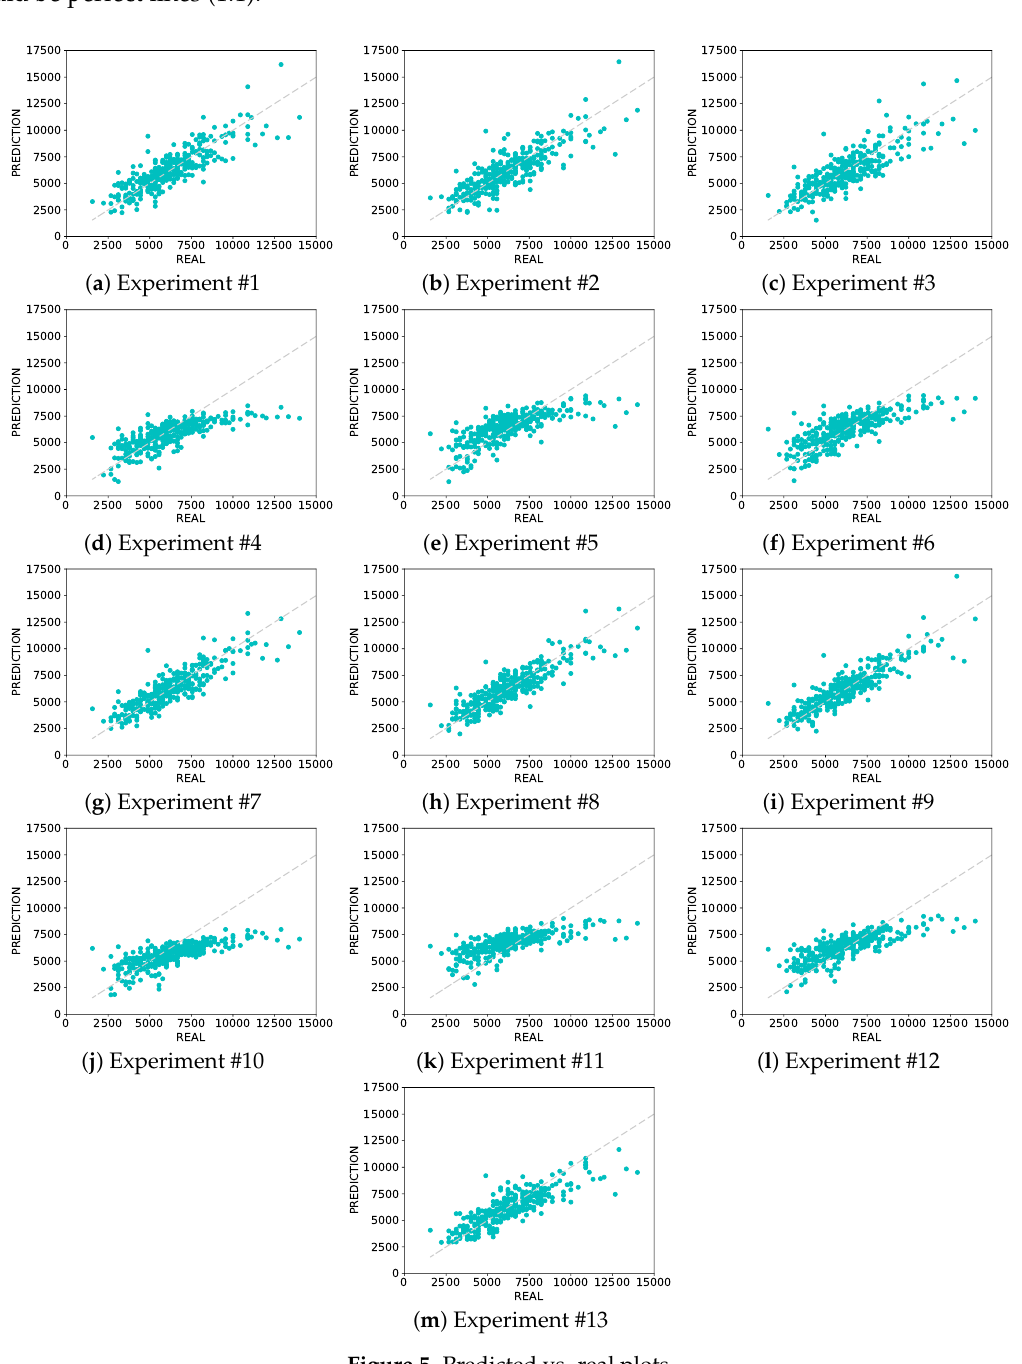
Figure 5. Predicted vs. real